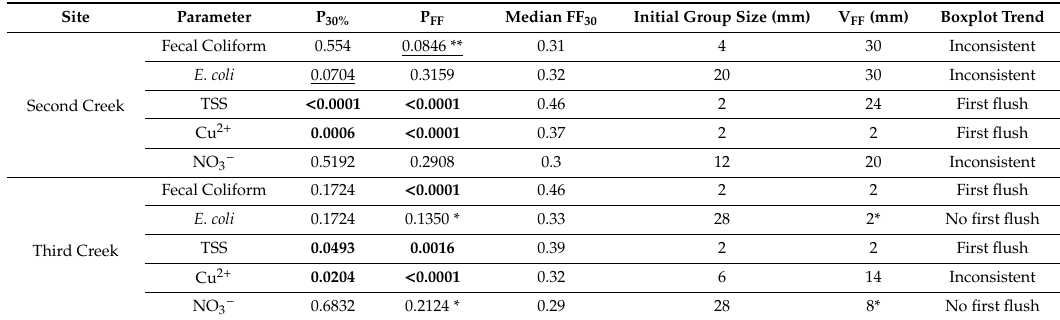
Table 3. Summary of analysis